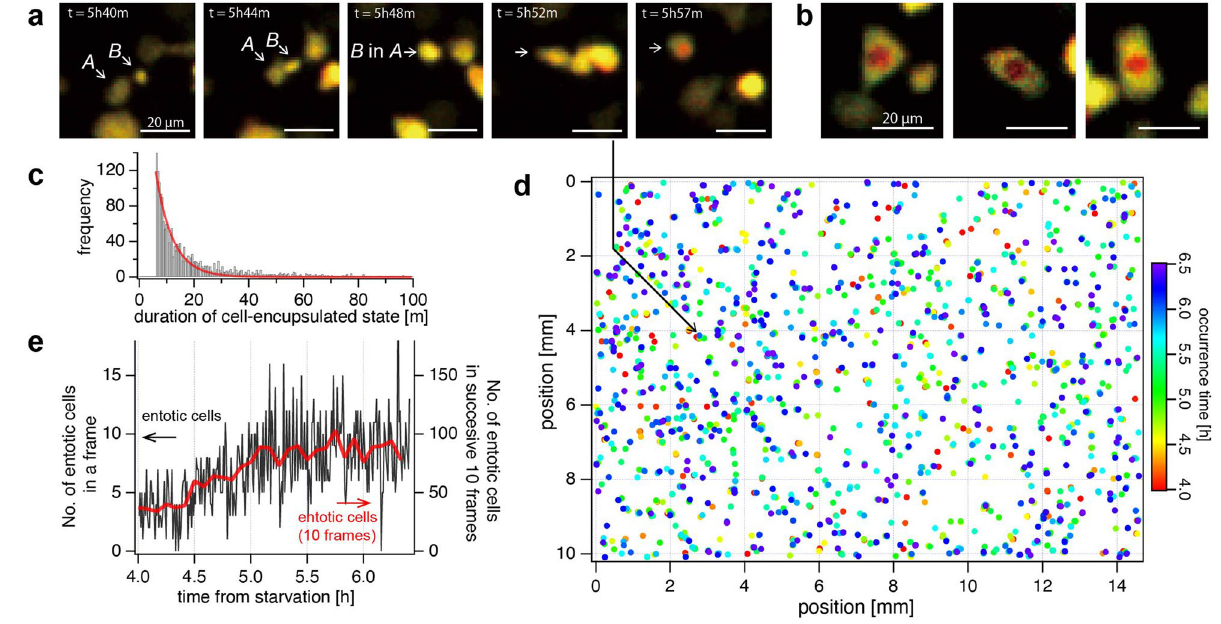
Figure 6. Detection and analysis of entotic event of D. discoideum . Entotic events were detected in the same image-set as Fig. 5 from 1st to 300th frame ( t = 4h00m–6h29m30s). ( a ) An example of entotic event observed from 5h40m to 5h57m. The larger cell marked with A came into contact with the smaller cell marked with B , and the two cells have unified at t = 5h48m. Within the next ten minutes, the inside of the unified cell turned red. ( b ) Three examples of the typical color appearance of entotic cells. ( c ) Histogram of the time duration of “red-cell”-encapsulated state. ( d ) Spatiotemporal distribution of the occurrence of detected entotic events in the entire FOV. The Rainbow color table represents the time of occurrence. ( e ) The temporal evolution of the number of entotic events detected in each frame (black line) and in successive 10 frames (red